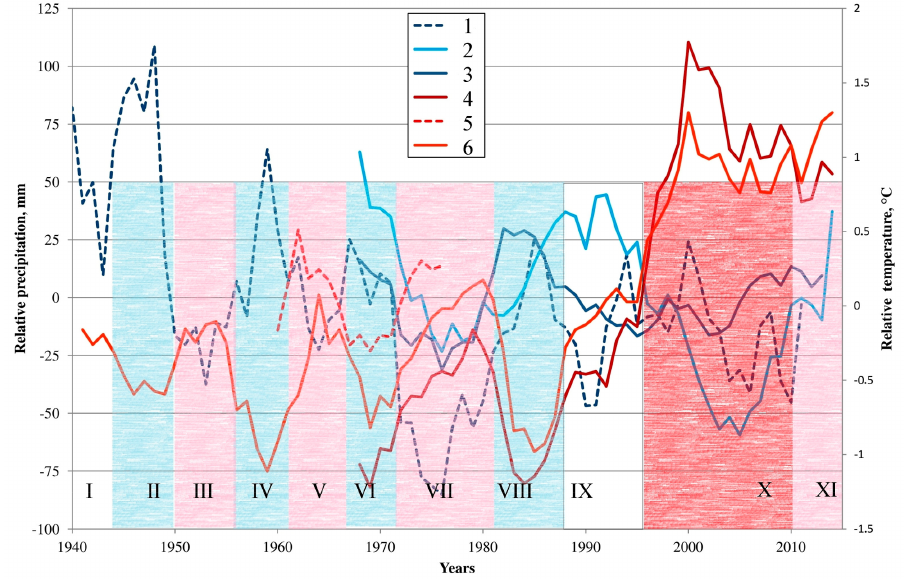
Figure 4. Changes in the annual precipitation and the average summer temperatures (values relative to the average for the periods of observation) according to the data from the Bertek, Kosh-Agach, and Mugur-Aksy meteorological stations. The data from Bertek was prolonged by the usage of data from the Katon-Karagaj (precipitation) and Kosh-Agach (temperature) meteorological stations, which were highly correlated with the Bertek data. Annual precipitation, mm: 1 : Bertek, 2 : Mugur-Aksy, 3 : Kosh-Agach; average summer temperatures: 4 : Mugur-Aksy, 5 : Bertek, 6 : Kosh-Agach. Roman numerals (I–XI): climatic phases. Blue: comparatively favorable for the glaciers; white: neutral; pink: negative; red: strongly negative.